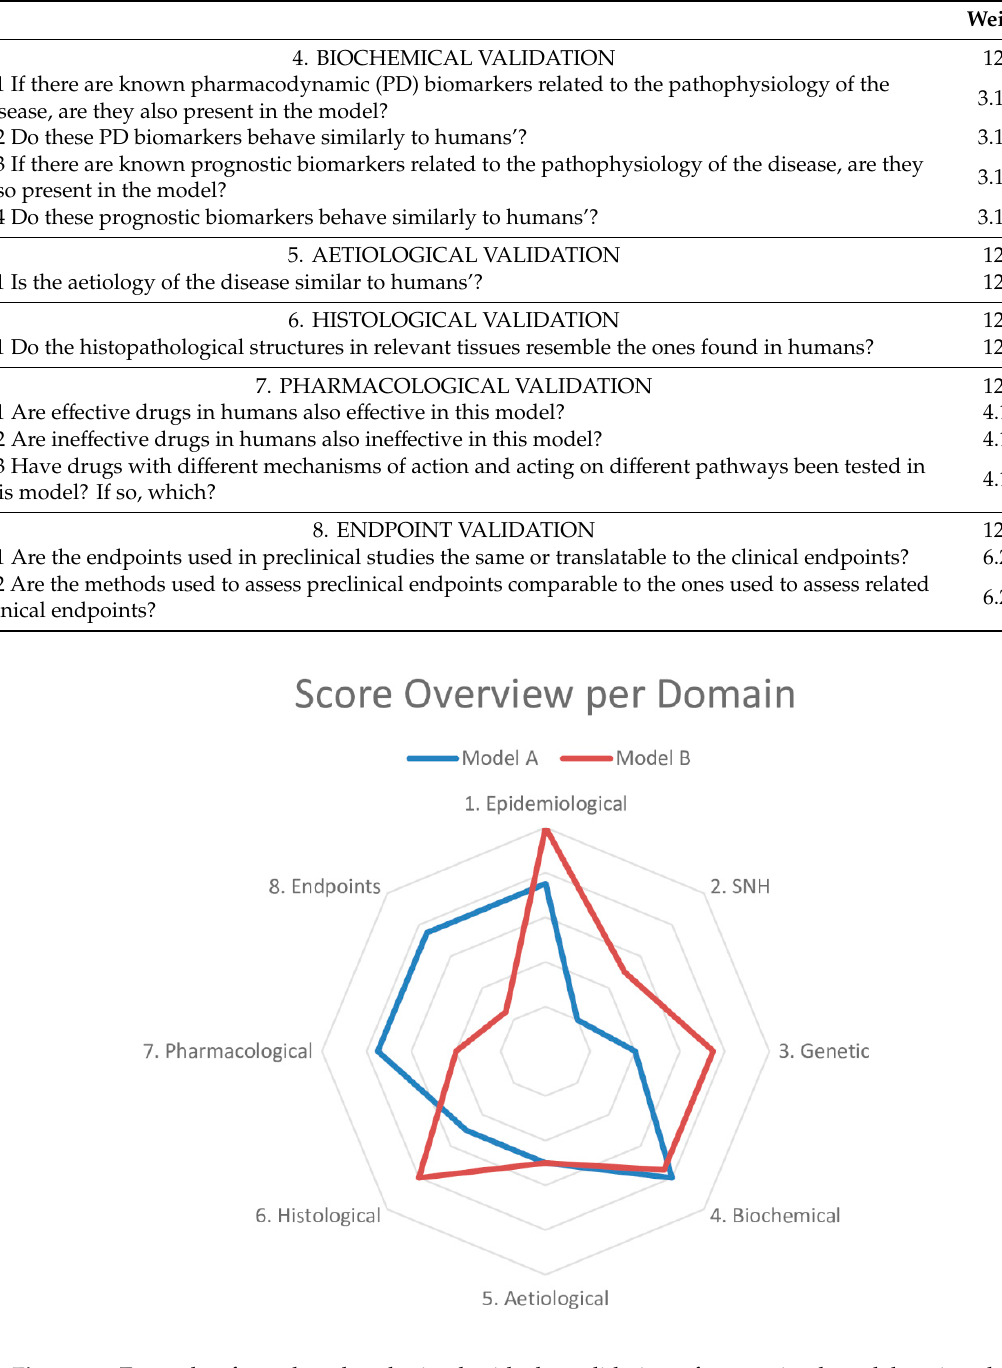
Figure 1. Example of a radar plot obtained with the validation of two animal models using the Framework to Identify Models of Disease (FIMD). SNH—Symptomatology and Natural History. Extracted from Ferreira et al.